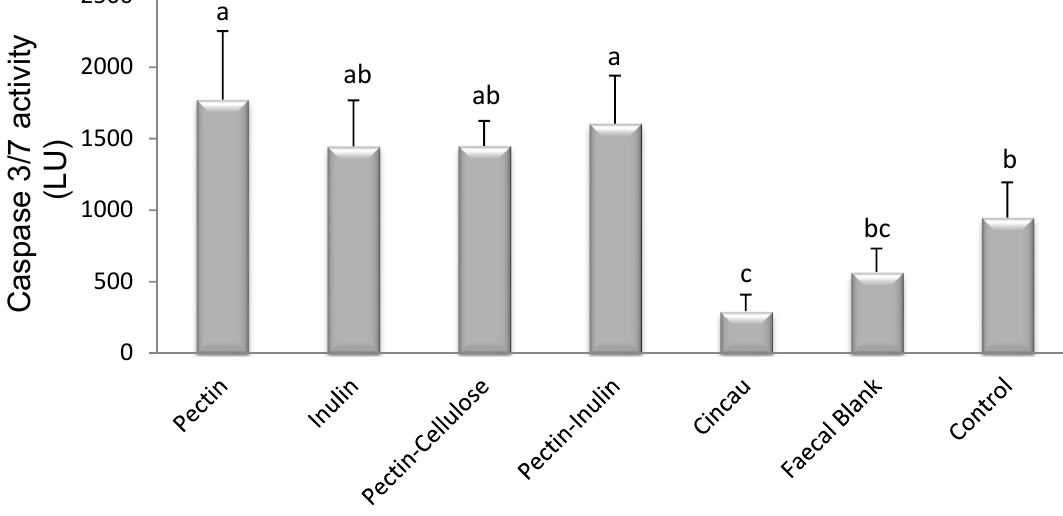
Figure 4. Effects of dietary fibre/s FS on caspase 3/7 activity. Cells were seeded 1 day before the treatment with FS (day 0), then incubated for 48 h in media containing 20% FS. Caspase-3 and -7 activities were measured using the Caspase-GloR 3/7 assay kit (Promega, USA). Control is cells incubated in media without FS. The bars represent the mean, and the lines are SEM of three independent experiments each performed in triplicate. Data points denoted by different superscripts (letters above the bar) differ significantly with p < 0.05. LU, Luminescence units